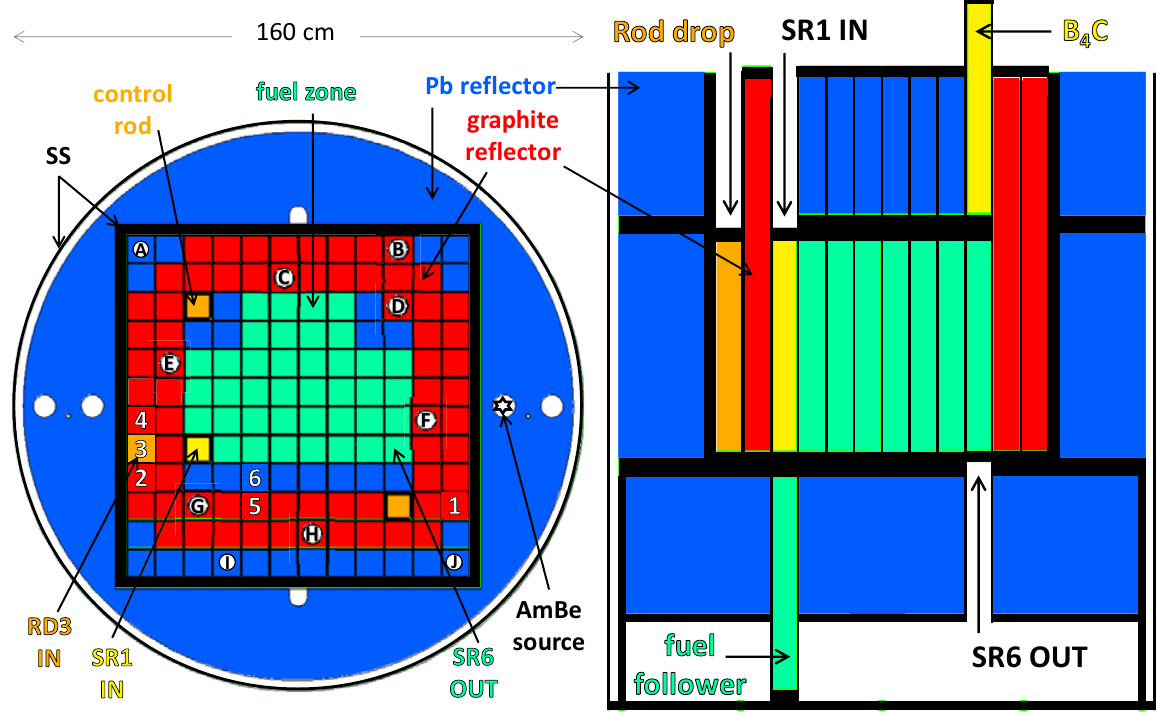
Figure 1. Left: horizontal view through the core mid-plane of the VENUS-F CC12 core with SR1 and rod drop (in location No. 3) inserted. The six optional locations of the rod drop system are indicated with white numbers (1-6). The ten detectors are indicated with black letters (A-J). Right: vertical view of the VENUS-F CC12 core through the plane passing the extracted safety rod SR6, inserted SR1 and rod